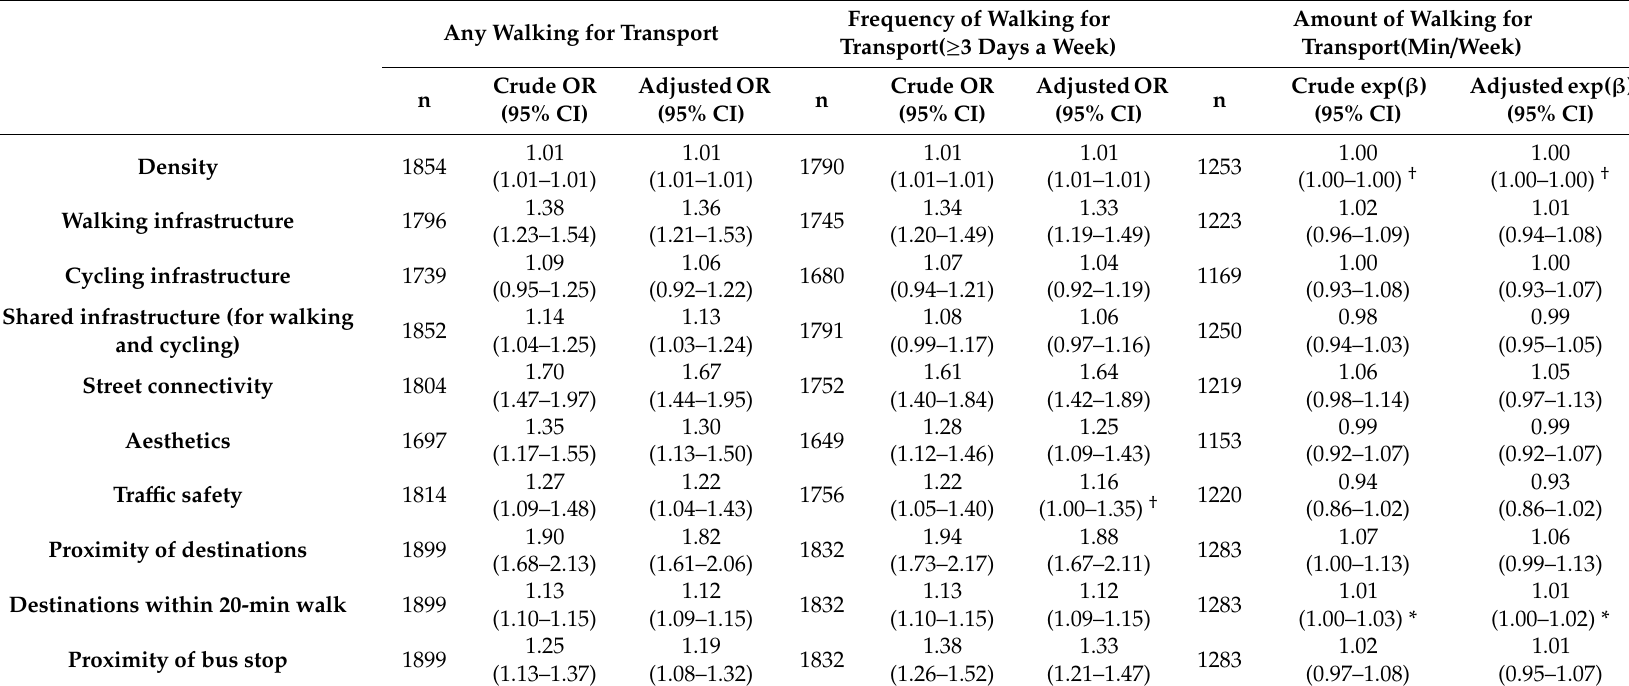
Table 3. Associations between perceived neighborhood environmental attributes and any walking for transport, frequency of walking for transport, and amount of walking for